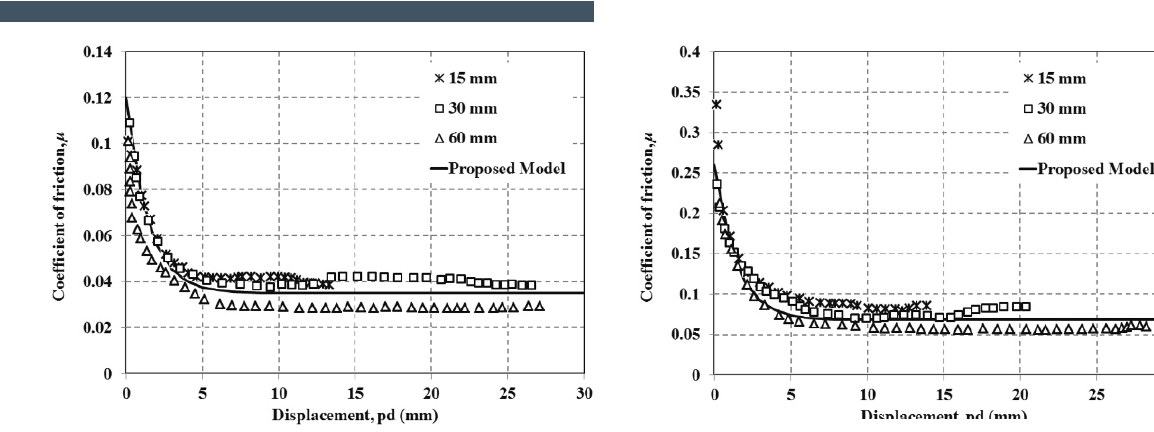
Figure 6. Coefficient of friction versus pullout displacement curves for hooked fiber and normal strength SCC.